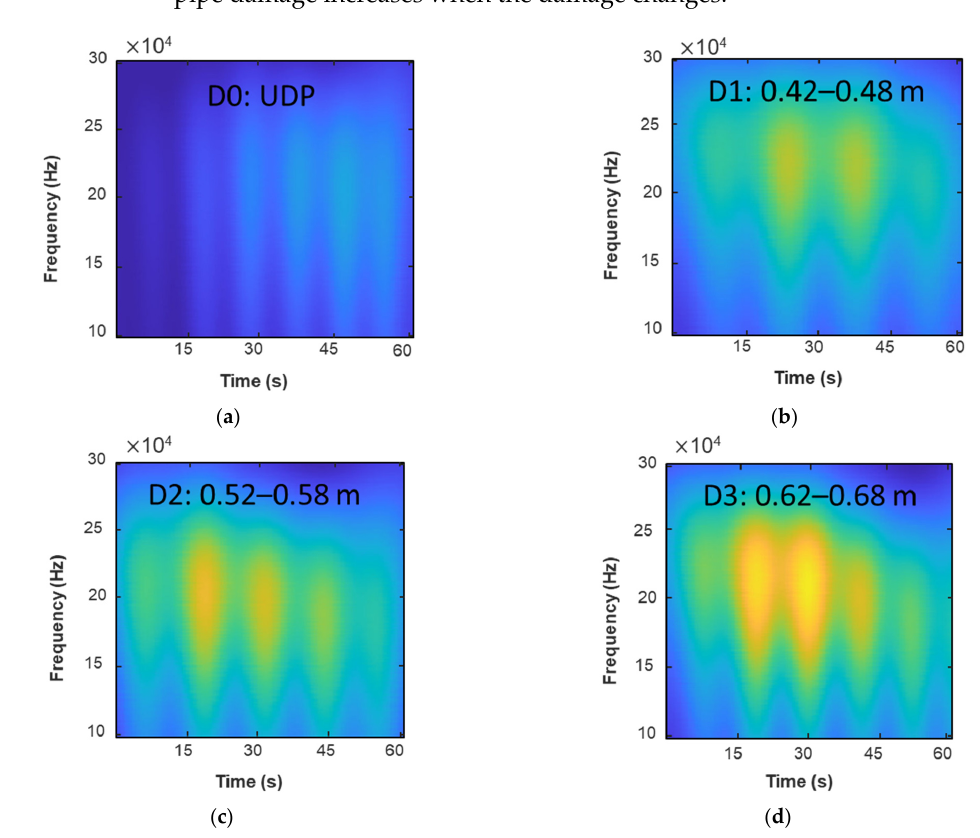
Figure 19. The time–frequency spectrogram (TFS) of the UDP/DP: ( a ) UDP, D0; ( b ) DP, D1; ( c ) DP, D2; and ( d ) DP, D3.